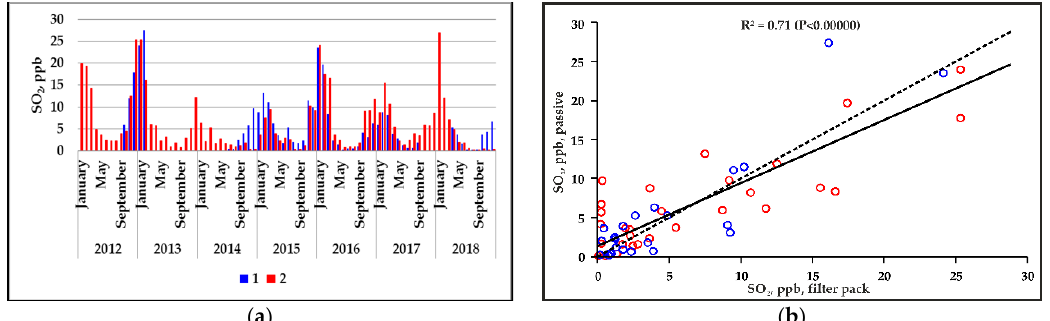
Figure 5. Seasonal variability of the sulfur dioxide concentration at the Irkutsk monitoring site, shown in ( a ); correlation of the concentrations obtained using the passive sampling and filter pack methods ( b ). 1—Passive method; 2—Filter pack method. The red circles on the graph show the data obtained during the two-week exposure of the passive sampler, and the blue circles show the data obtained during the monthly exposure of the passive sampler, while the solid line is the graph of the estimated regression model, and the dotted line is the expected relationship with slope = 1 and intercept = 0. The graphs show the quality value of the linear approximation R 2 and its statistical support P.